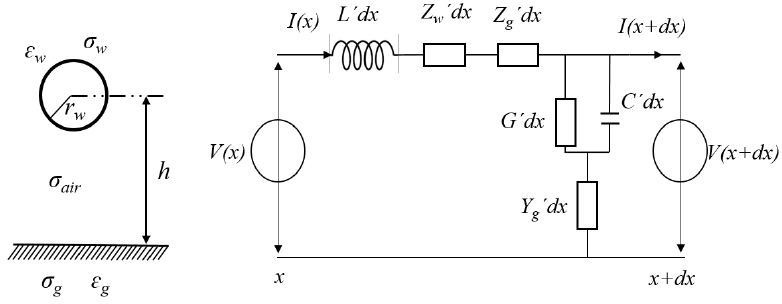
Figure 2. Single-conductor transmission line cross-section with equivalent